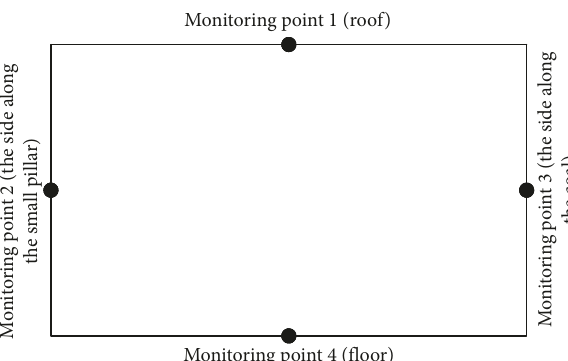
Figure 2: Schematic cross section showing the layout of moni- toring points in the rock surrounding the